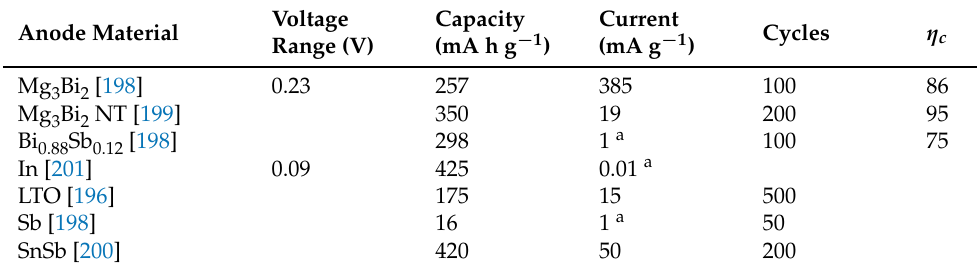
Table 7. Anode materials for Mg-based